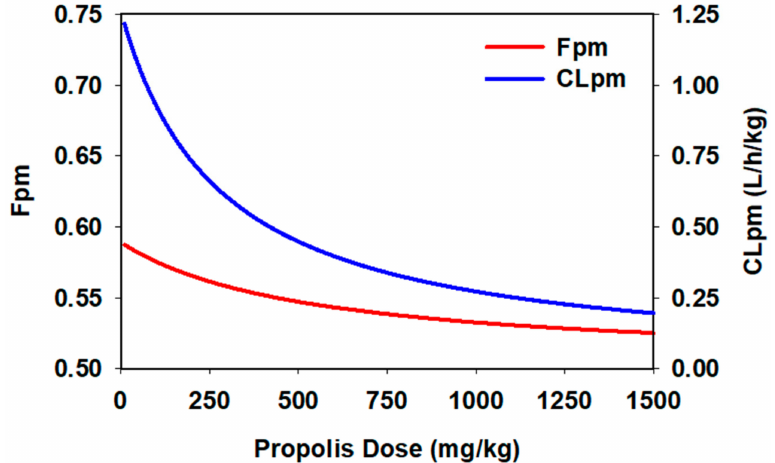
Figure 2. Predicted conversion fractions of DLX to 4-HD via the pre-systemic ( F pm ) and systemic ( CL pm ) metabolisms according to the di ff erent administered doses of